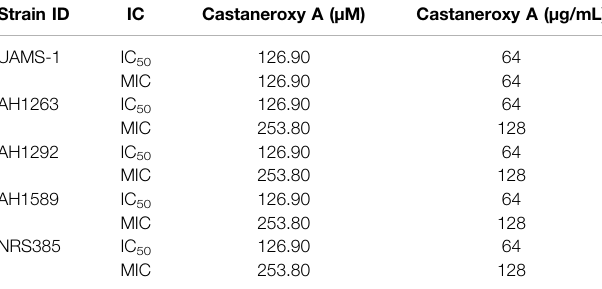
TABLE 2 | IC 50 and MIC values of castaneroxy A ( 1 ) against various S. aureus strains at 18 post-inoculation, based on optical density of growth cultures, reported both in µM and µg/mL for